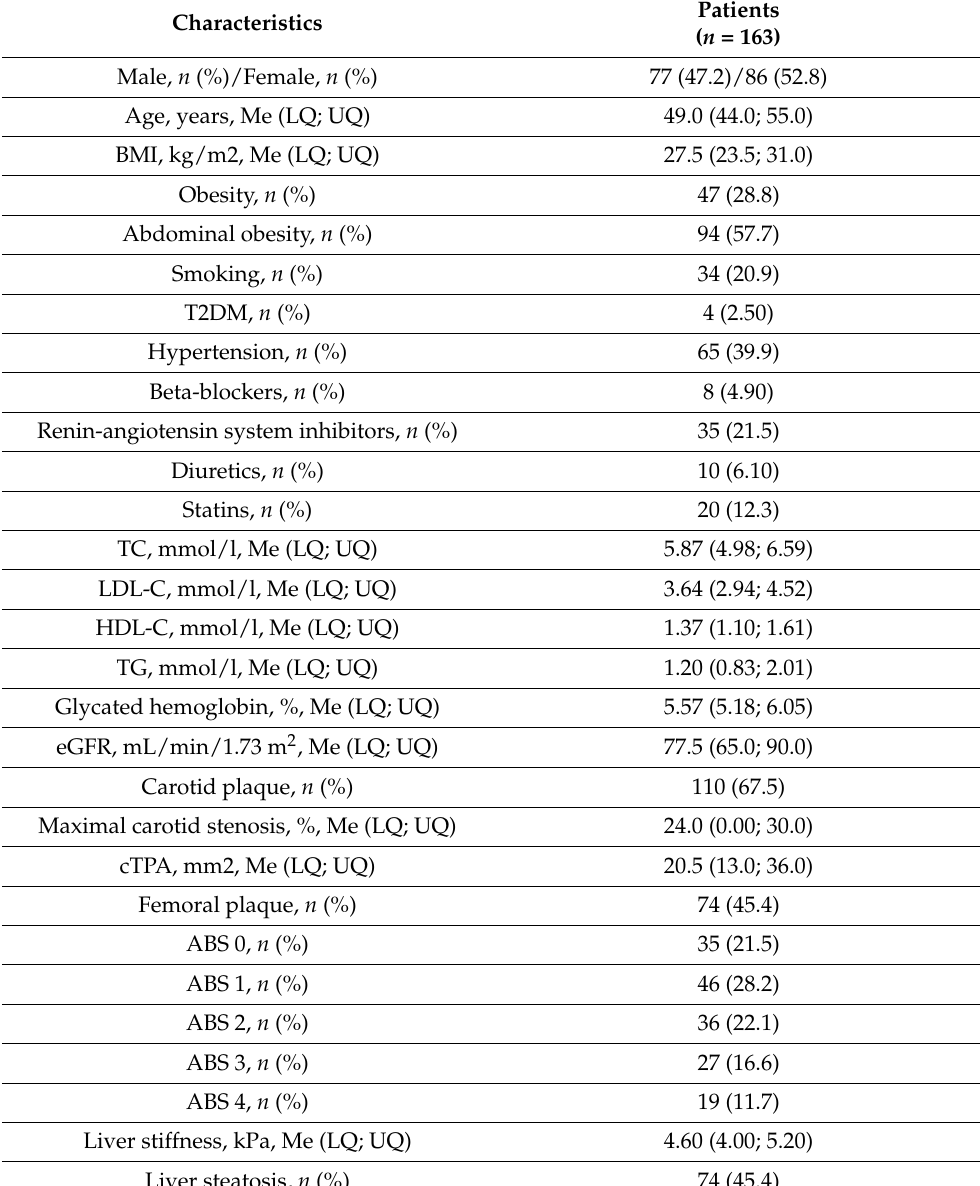
Table 1. Clinical characteristics of